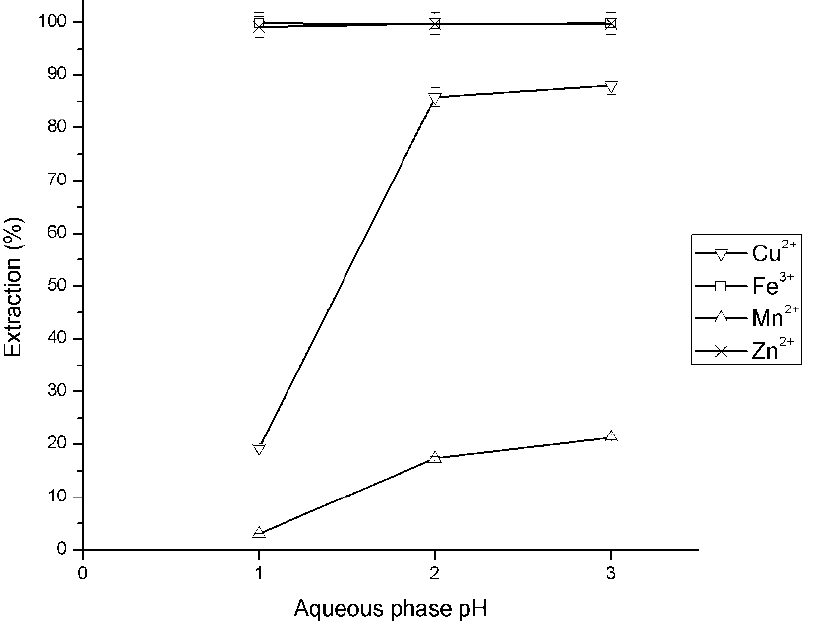
Figure 1. Effect of initial pH on the extraction percentage of metals from aqueous solution. Experi- mental conditions: R 4 NCy = 0.54 M, O/A = 1, 400 min − 1 , and 20 min of stirring time.